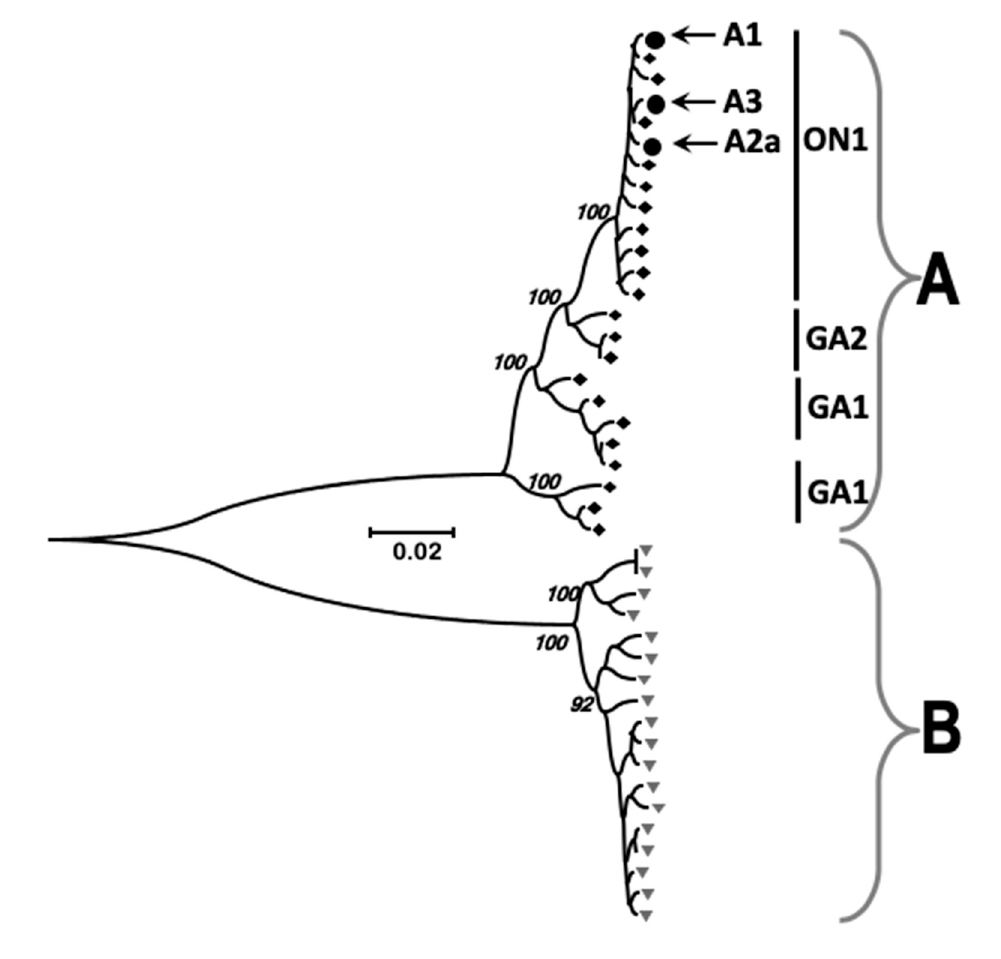
Figure 3. Phylogenetic analysis of the sequence of the three clinical samples compared to examples from sub-group A and sub-group B viruses. The three clinical isolates are indicated with arrows and the group A and B references full genome sequences from the Gene-bank database. Neighbor-joining / Kimura two-parameter phylogenetic analysis was performed using the MEGA7 software package. The data indicated that the three samples sequenced contained HRSV most similar to the ON1 isolate.